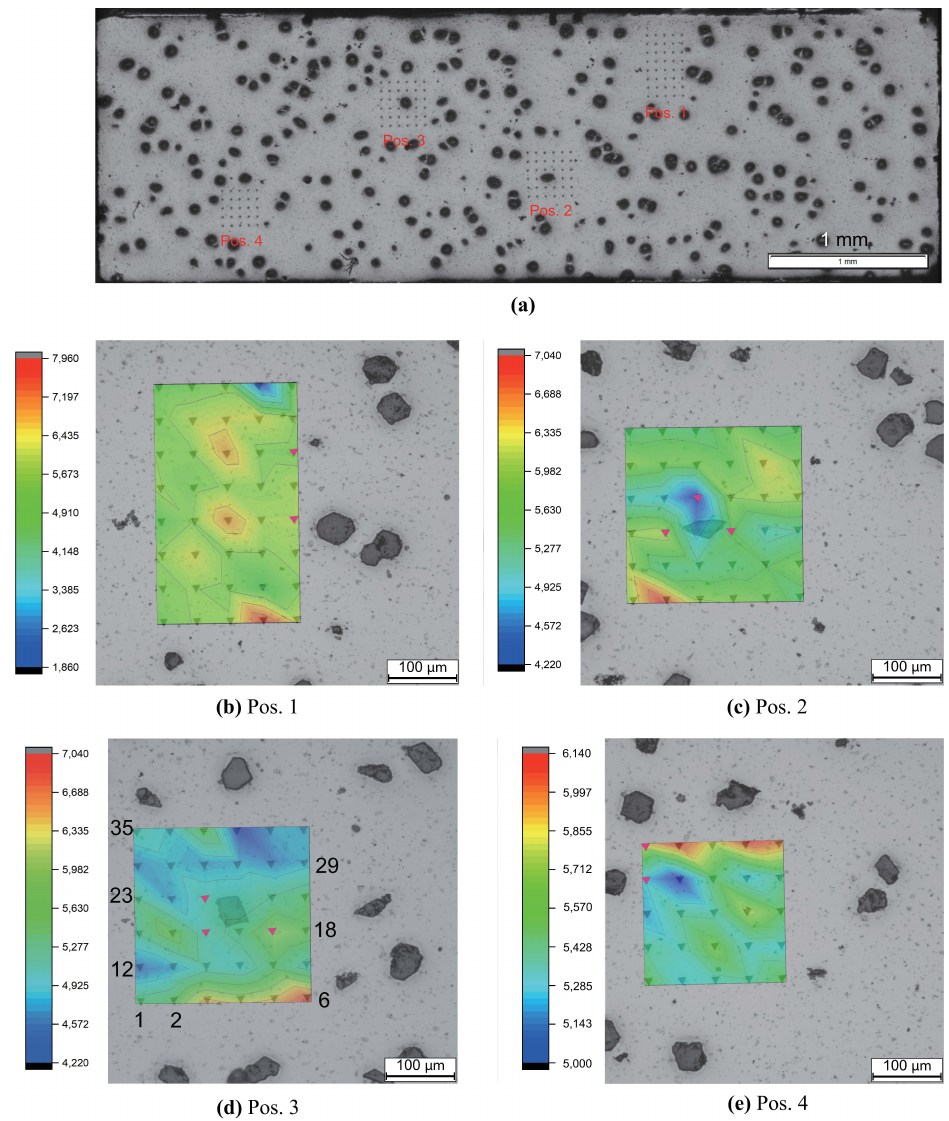
Figure 6. Hardness distribution from HV0.3 nanoindentation tests after graphitization of diamonds (type-II quasi-brittle behavior): ( a ) the four measured positions (Pos.1 to Pos.4) on the surface; ( b – e ) the hardness distributions correspond to